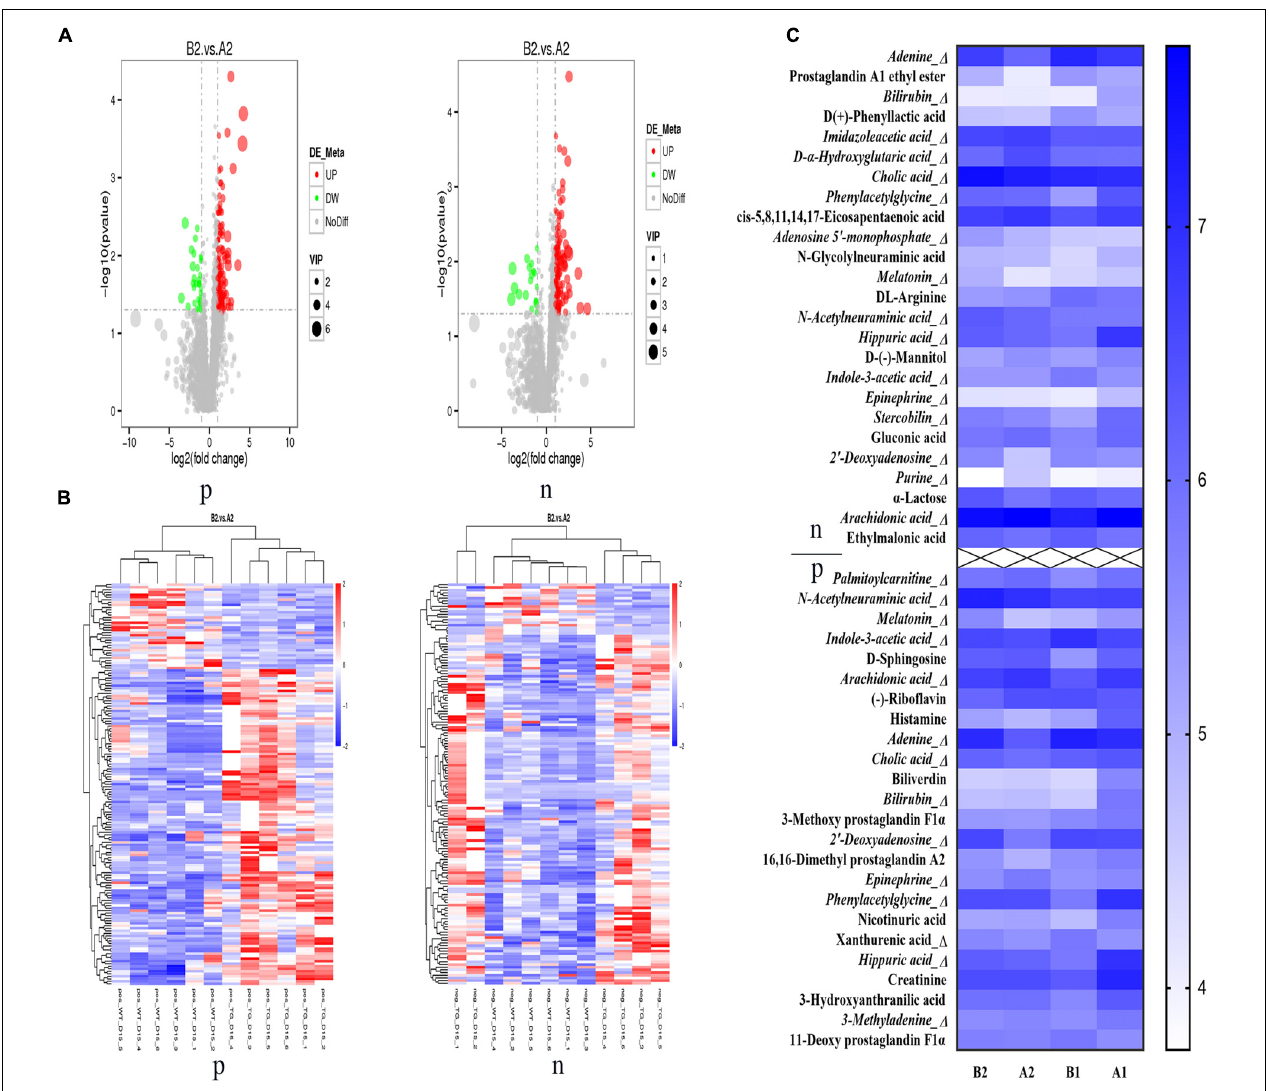
FIGURE 5 | Restoration of metabolic patterns by IL-37b in AD. (A) Metabolite volcano map. (B) Metabolite clustering heat map. (C) Relative abundance of differential metabolites among different groups with Log 10 of peak intensity; p: positive ion mode, n: negative ion model. A1, stool samples of wild type mice at day 1 without MC903 stimulation; B1, stool samples of IL-37b Tg mice at day 1 without MC903 stimulation; A2, stool samples of wild type mice at day 15 with MC903 inducing AD model; B2, stool samples of IL-37 Tg mice at day 15 with MC903 inducing AD model. N = 6